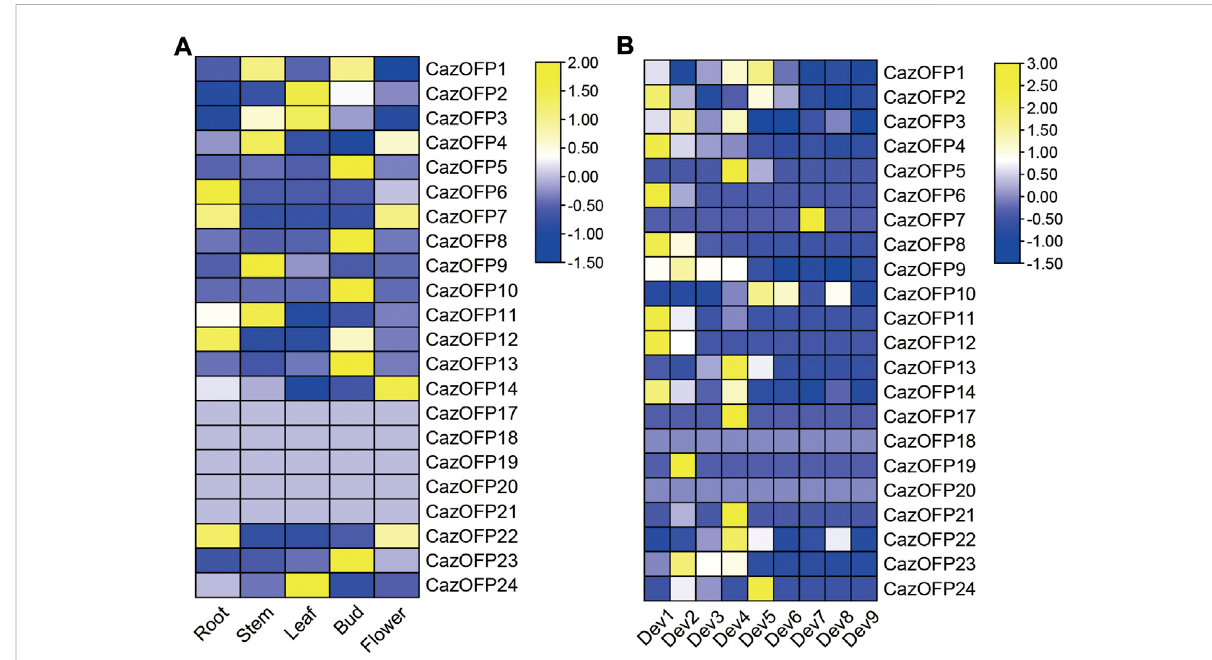
FIGURE 6 Expression pattern of OFP genes in pepper.[ (A) Roots: developing roots; Stems: developing stems; Leaves: mature leaves; Bud: closed fl ower buds; Flowers: open fl owers. (B) Dev1: Fruits with length between 0 – 1 cm; Dev2: Fruits with length between 1 – 3 cm; Dev3: Fruits with length between3 – 4 cm;Dev4:Fruitswithlengthbetween4 – 5 cm;Dev5:maturegreenfruit;Dev6:Fruitatbreaker(fruitturningred);Dev7:Fruitatbreaker plus 3 days; Dev8: Fruit at breaker plus 5 days; Dev9: Fruit at Breaker plus 7